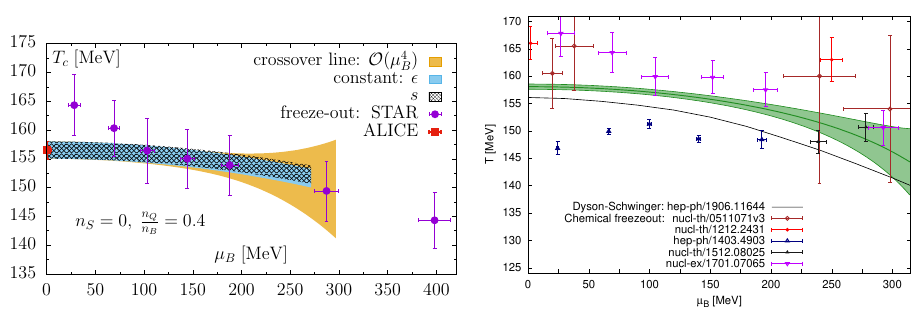
Figure 2. (Ref. [11]) Overview of the di ff erent determinations of the κ 2 and κ ffi cients as defined in 4 coe equation (4). The values are taken from Ref. [10–14]. Green points correspond to determinations from imaginary chemical potential, while resuls shown in blue were obtained by the Taylor method.